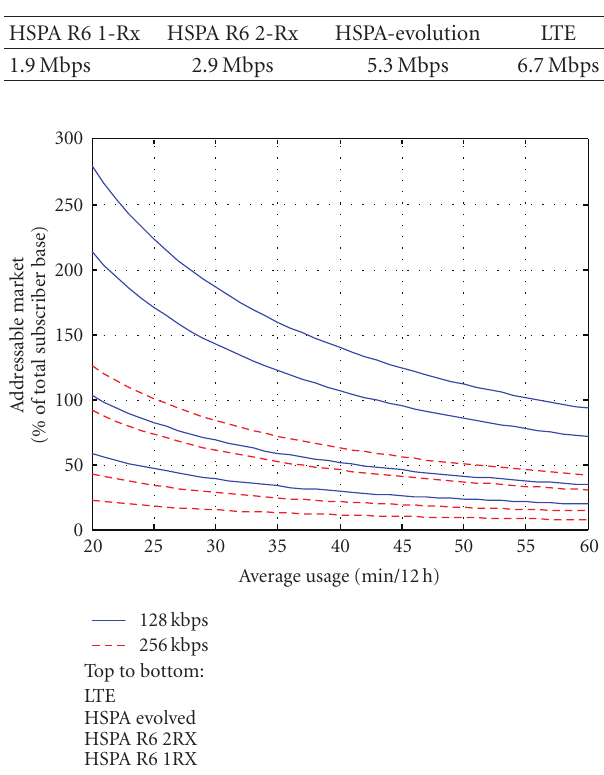
Table 6: Streaming capacity per cell and 5MHz.